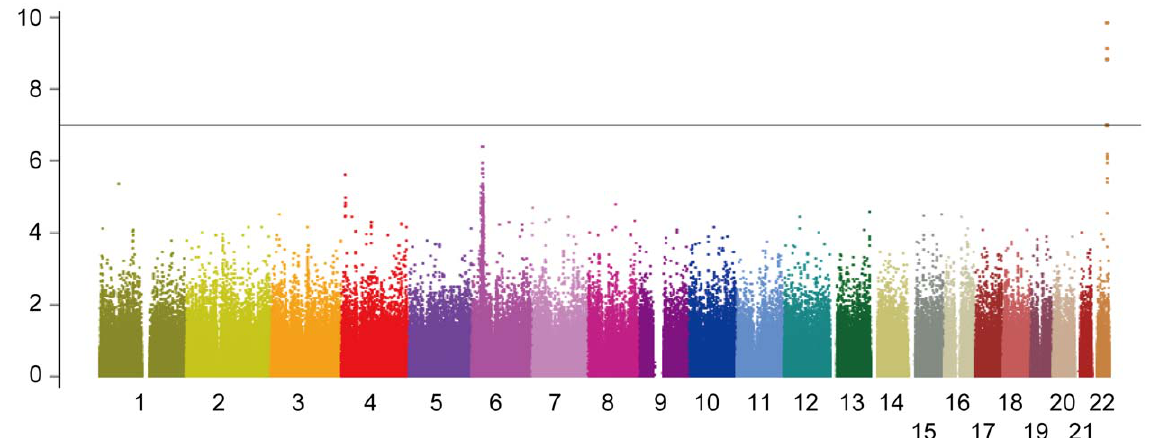
Figure 1. Manhattan plot of the GWA study. Association p -values are calculated by exact trend test and plotted along the chromosome in 2 log 10 scale. The horizontal line indicates Bonferroni-adjusted significance threshold ( p =1.03 6 10 2 7 ).